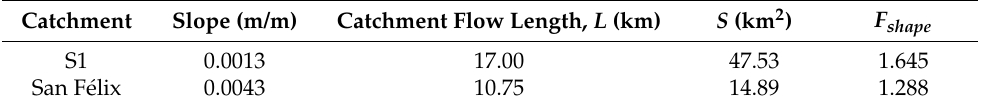
Table 9. Catchments shape factors.